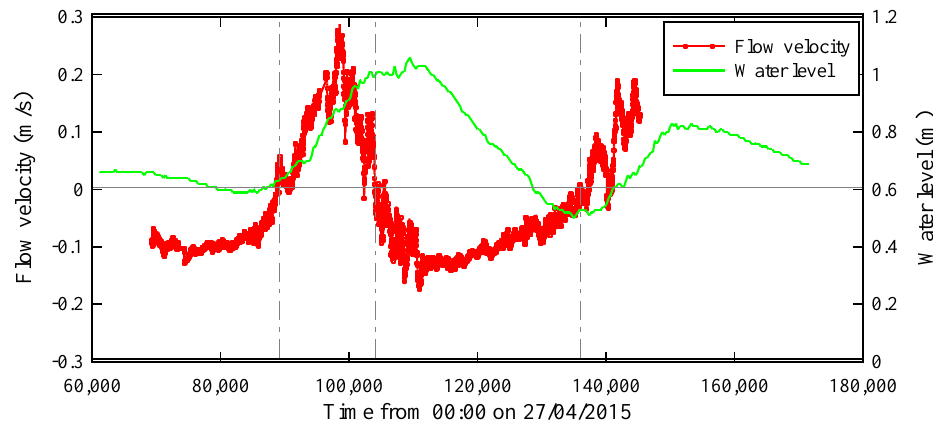
Figure 4. Time series of mean flow velocity magnitude and water level at Currimundi Lake.